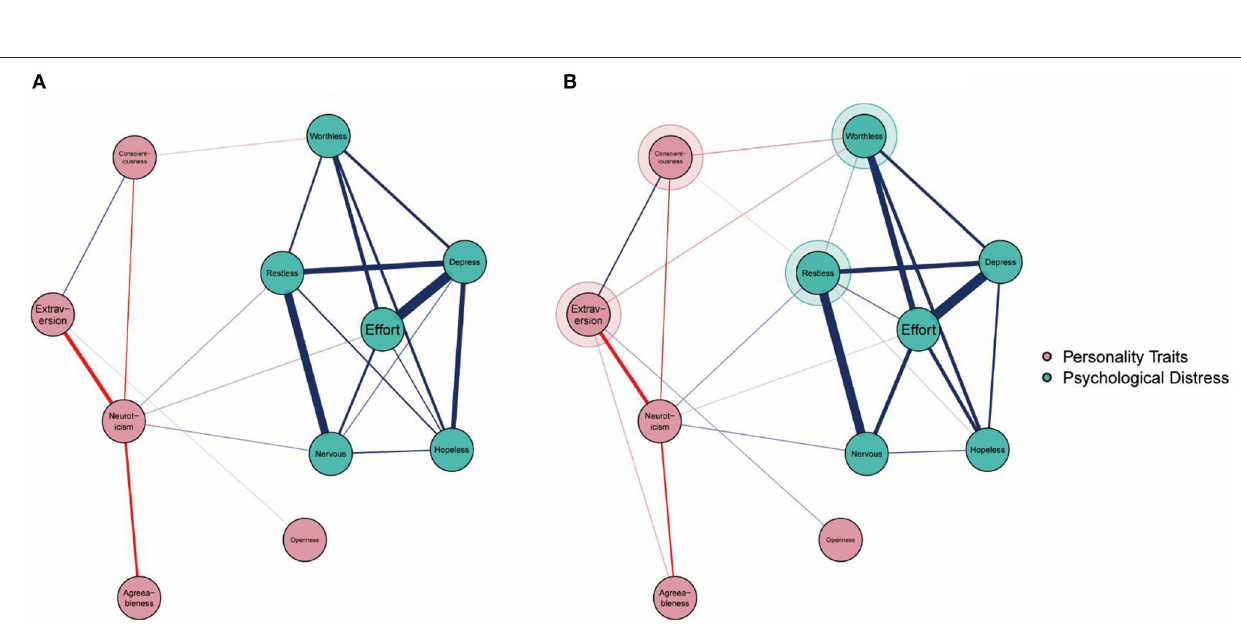
conscientiousness was directly negatively linked to